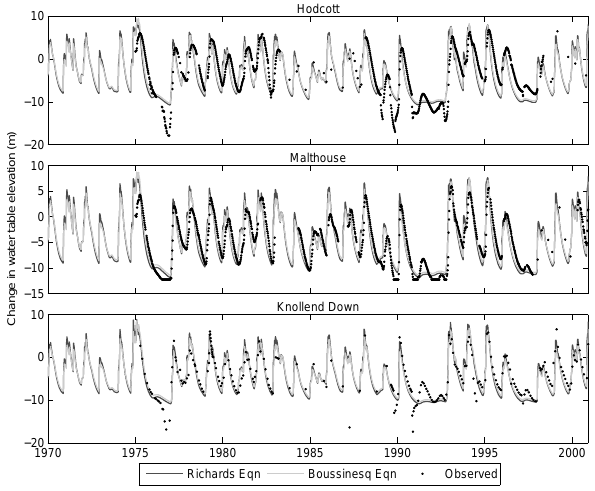
Fig. 2. Performance of Richards’ equation model at simulating change in water table elevation. Performance of the Boussinesq model is also shown, validating the premise of the model emula- tion strategy.